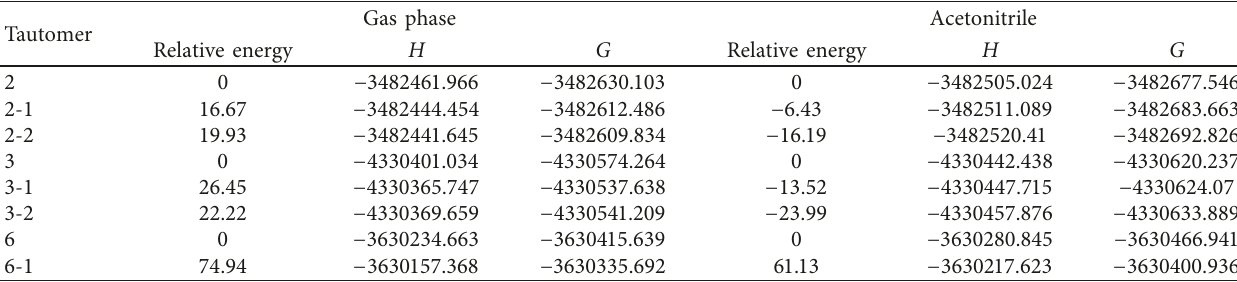
Table 5: Thermodynamic parameters in (kJ/mol) of the tautomers calculated using less-expensive wB97X-D/6-31G(d) computational model.